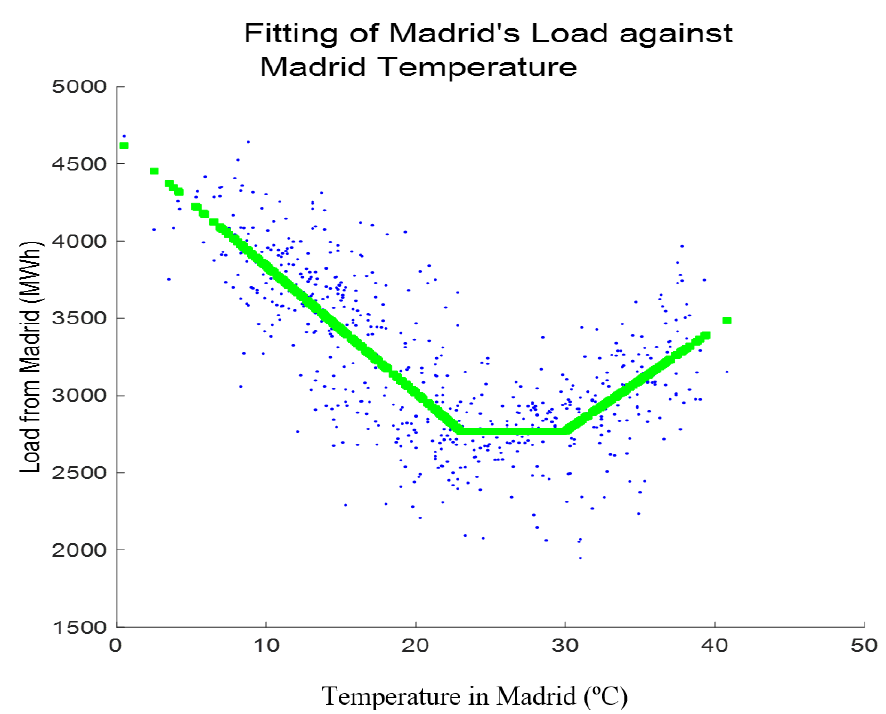
Figure 4. Scatter plot of load from the region of Madrid against temperature from the Madrid weather station. The linearization through HDDs and CDDs is shown in green.